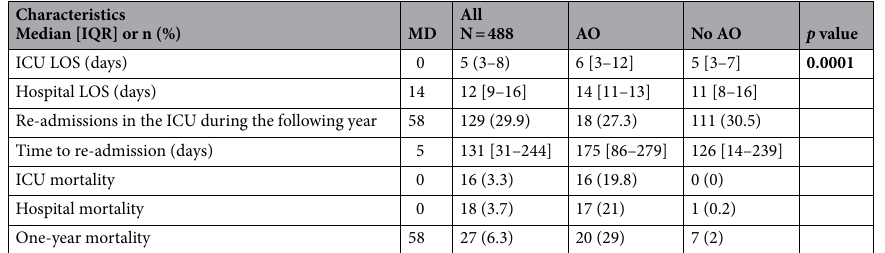
Table 4. Outcome at discharge and during the one-year follow up. Significant values are in [bold]. The p values were obtained by univariate logistic regression and reflect associations with the occurrence of adverse outcomes. As “adverse outcome” was a composite criterion including death, no statistical tests were performed for re-admissions, ICU mortality, hospital mortality, or one-year mortality. IQR interquartile range, MD missing data, AO adverse outcome defined as death or use of life-sustaining treatments, SCD sickle cell disease, MBP mean arterial blood pressure, GCS Glasgow Coma Scale, ASAT aspartate transaminase, ALAT alanine transaminase, LDH lactate dehydrogenase, PT prothrombin time, ICU intensive care unit, NSAIDs nonsteroidal anti-inflammatory drugs, RBC red blood cells, LOS length of stay, ACS acute chest syndrome, VOE vaso-occlusive event, NIV non-invasive ventilation, MV endotracheal mechanical ventilation, RRT renal replacement therapy, ECMO extracorporeal membrane oxygenation, SAPS II Simplified Acute Physiology Score